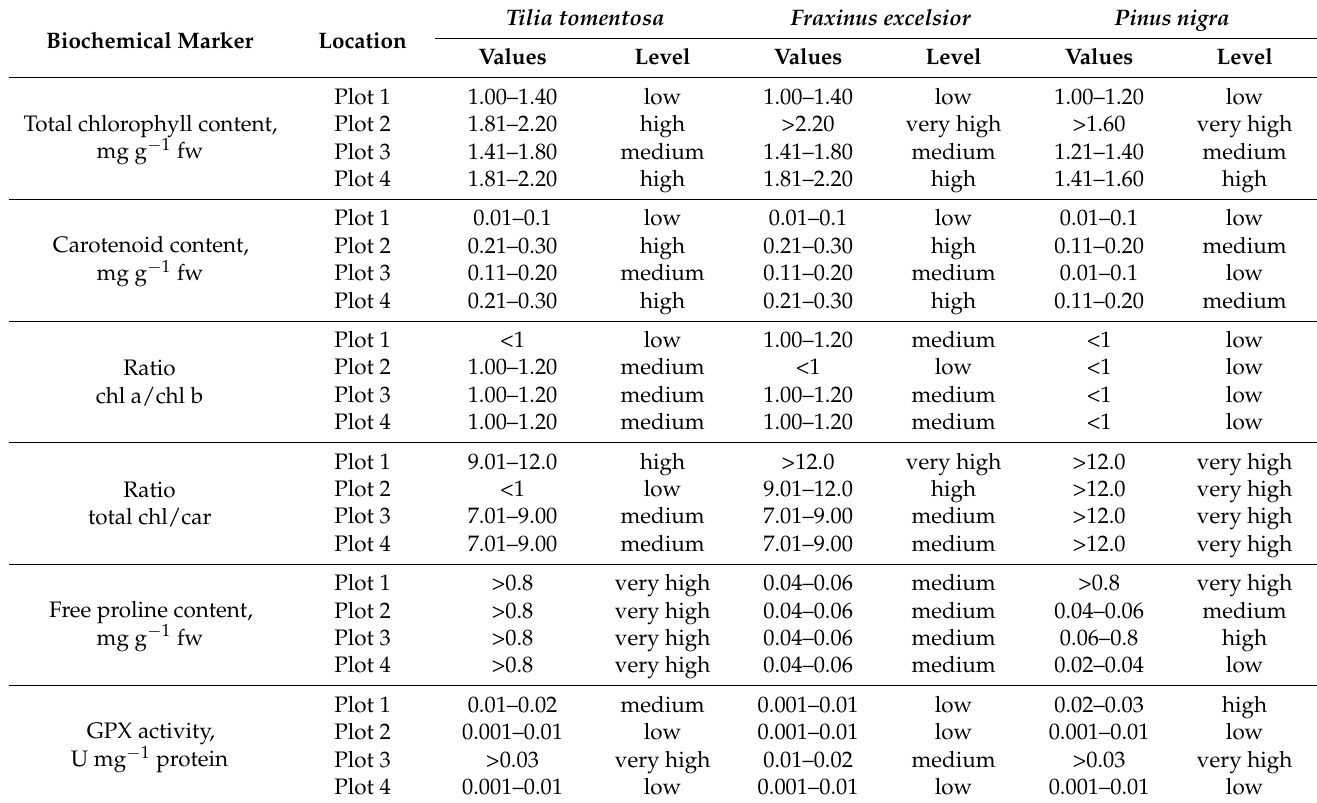
Table 3. Reference scale for early determination of the anthropogenic impact extent based on the different levels of biochemical stress markers in urban